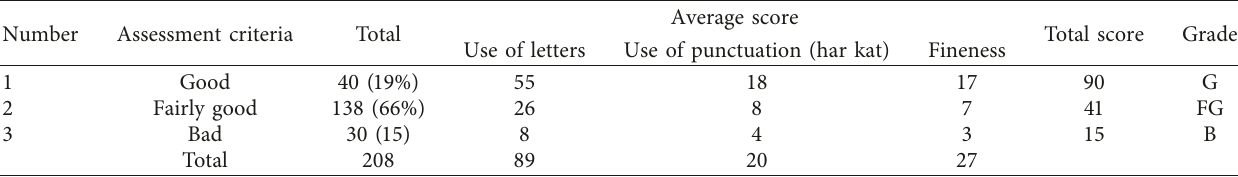
Table 2: Assessment of Quranic reading skills of 3 rd semester students in